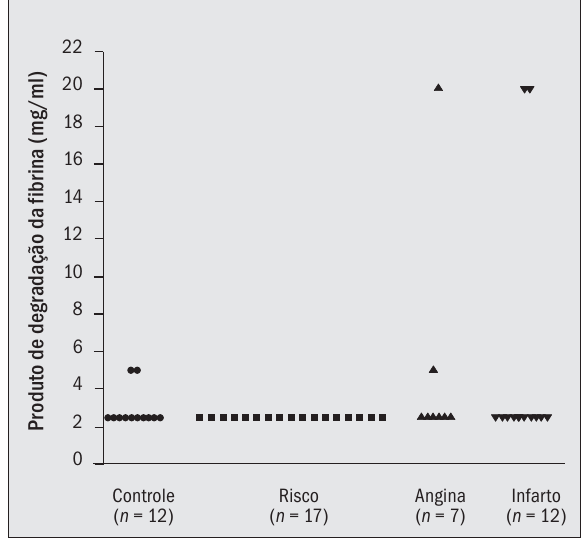
Figura 6 – Resultados da determinação semiquantitativa dos produtos de degradação da fibrina nos grupos de controle, de risco, com angina e com infarto, utilizando a técnica de aglutinação em